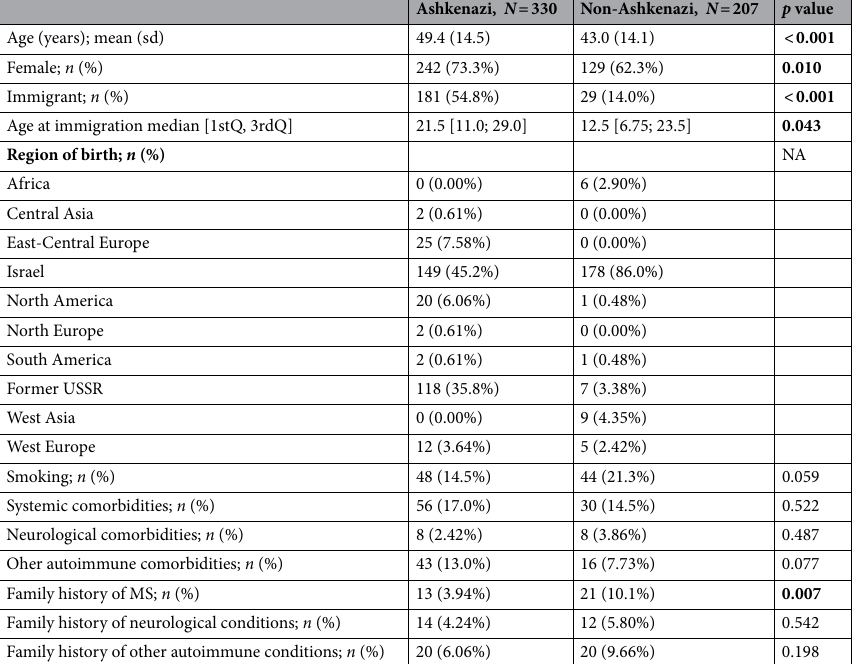
Table 1. Characteristics of study population. Comparison of demographic characteristics in Ashkenazi patients vs. non-Ashkenazi patients. Variables that were normally distributed according to Shapiro test ( p value < 0.05) are presented in the format of mean (SD) and compared using Student T-test. Non-normal variables are presented by median [1st quartile, 3rd quartile], and compared using Mann-Whitney U test. Categorial variables are compared using Chi-squared test and presented with count (%). p values in bold denote statistical significance ( p < 0.05). USSR Union of Soviet Socialist Republics, MS multiple